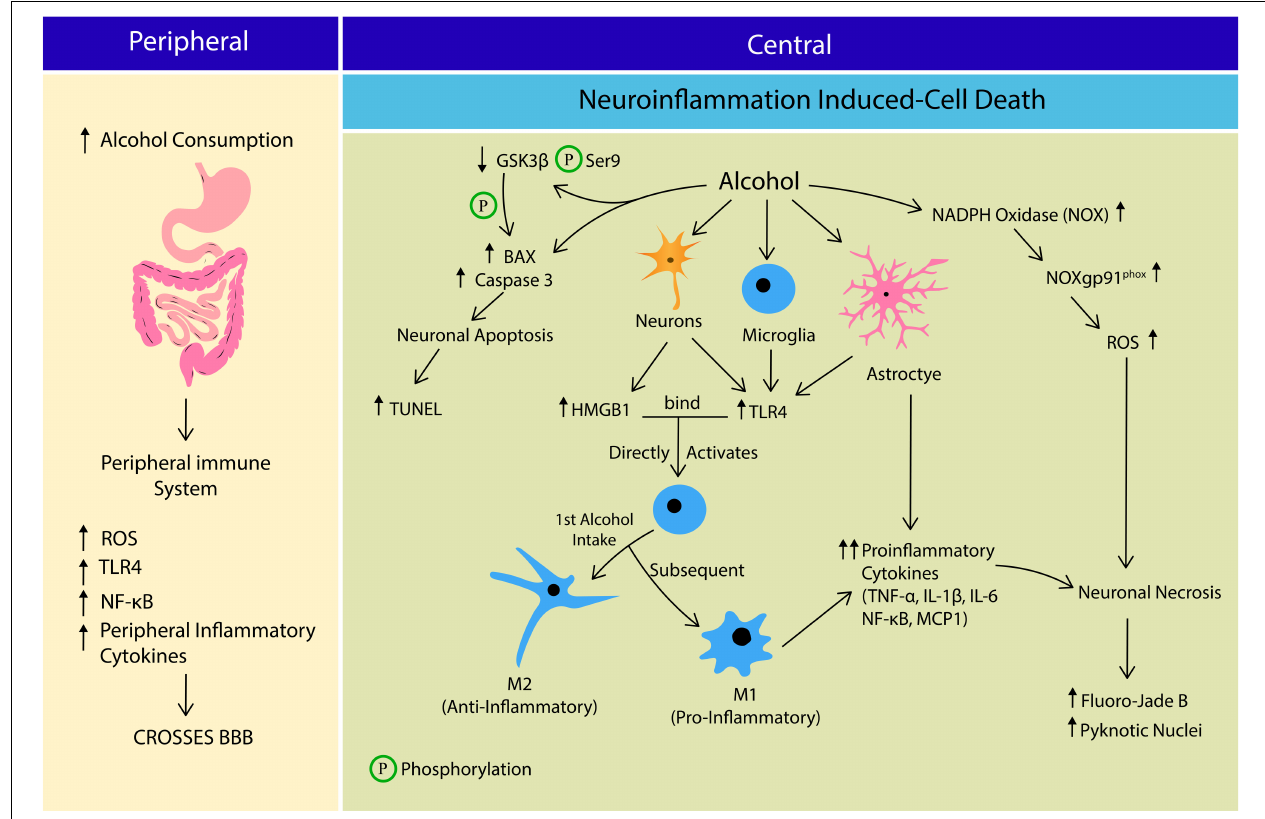
FIGURE 1 | The crosstalk between peripheral and central immune system in Alcohol Use Disorder (AUD) leading to cell death. Alcohol consumption increases the peripheral production of reactive oxygen species (ROS), Toll-like receptor 4 (TLR4), nuclear factor kappa-light-chain enhancer of activated B cells (NF- κ B) and inflammatory cytokines, which cross the blood brain barrier (BBB). At central nervous system, alcohol induces neuroinflammation that potentially leads to apoptosis or neurosis. Alcohol stimulates more B-cell lymphoma-2-associated X (BAX) formation, Caspase 3 expression and activates Glycogen synthase kinase-3 β (GSK3 β ) by reducing its Serine 9 phosphorylation. GSK3 β also directly phosphorylates BAX leading to neuronal apoptosis. Alcohol stimulates neuronal release of HMGB1 and TLR4 expression on microglia, astrocytes and neurons. HMGB1-TLR4 interaction activates microglia into; M1 phenotye (anti-inflammatory) during 1st alcohol intake, and M2 phenotype (pro-inflammatory) in subsequent alcohol exposure. M2 phenotype and astrocytes releases several pro-inflammatory cytokines including tumor necrosis factor-alpha (TNF- α ), interleukin 1 Beta (IL-1 β ), interleukin-6 (IL-6), NF- κ B and monocyte chemoattractant protein-1 (MCP1). Alcohol stimulates ROS production by increasing NADPH-dependent oxidase (NOX), NOXgp91 phox expression and activity, leading to oxidative stress. Collectively alcohol-induced neuroinflammation and oxidative stress causes neuronal death via apoptosis and necrosis